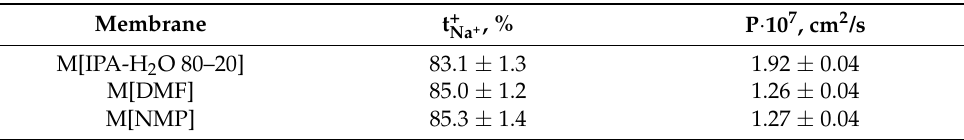
Table 4. Cation transport numbers ( t + , %) at 25 °C and hydrogen permeability (P, cm 2 /s) at RH = 95% and t = 25 °C for the investigated membranes.